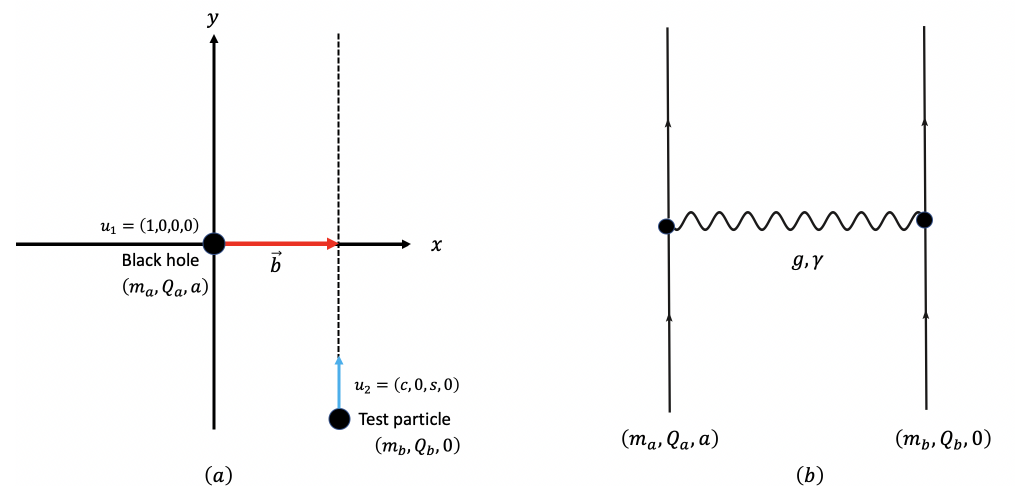
Figure 2 . (a) The coordinate system set up. We set z = 0 as the scattering plane and the impact parameter is aligned with the x axis. The black hole sitting at the origin has mass, charge and spin ( m ) and the scalar test particle has mass, charge ( m a , Q a , a amplitude computation. g and γ denote graviton amd photon exchange